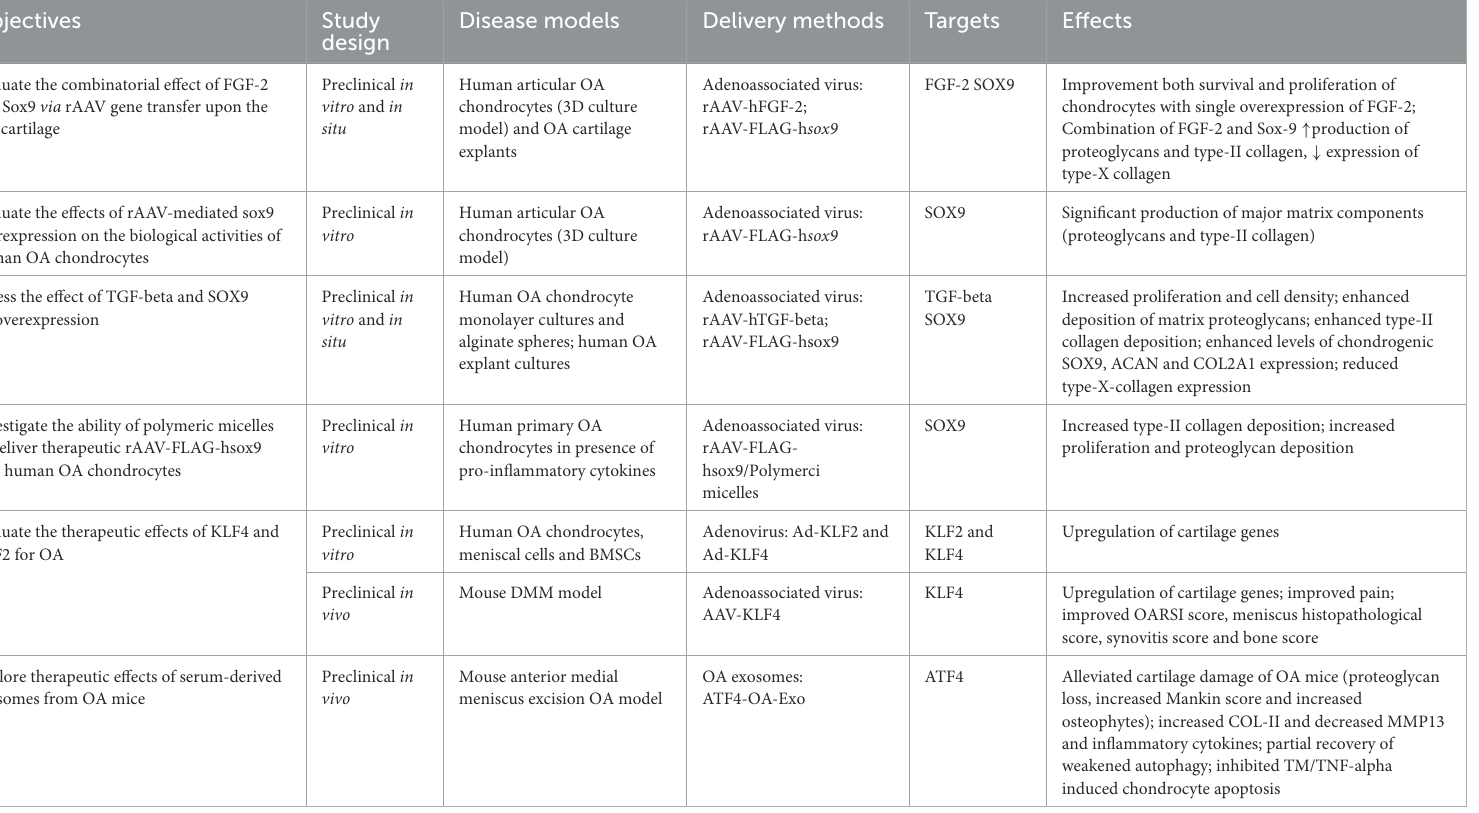
TABLE 4 Transcription